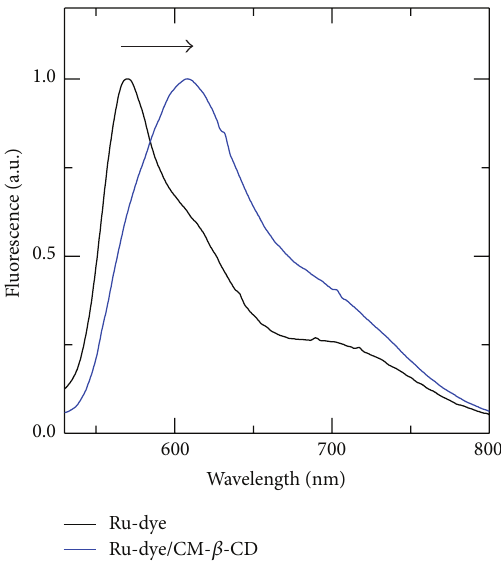
Figure 5: Fluorescence spectra of the Ru-dye-containing and Ru- dye/CM- 𝛽 -CD-containingdevicesfollowingexcitationwith450 nm light